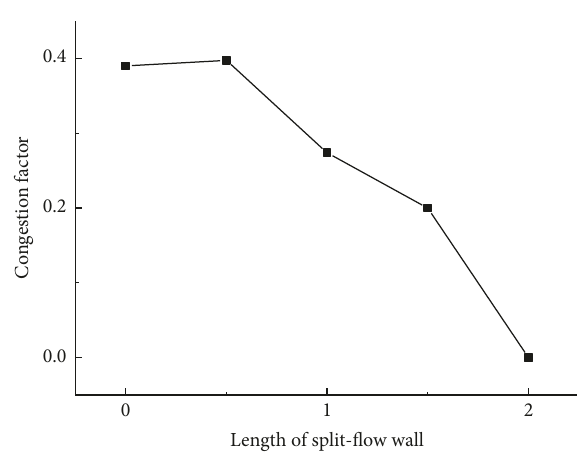
Figure 7: Congestion factor when 𝐷 = 0.5 , 𝜌 = 0.3 .